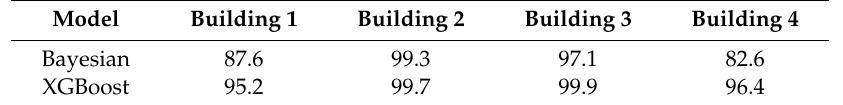
Table 2. The floor estimation accuracy of BWFP with Bayesian model in four di ff erent buildings (%). Model